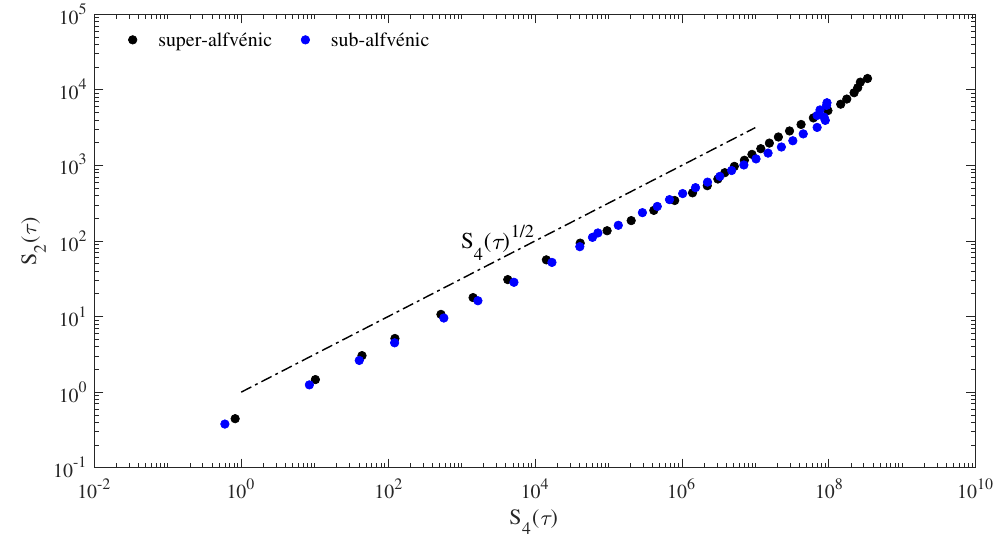
( i ) ( τ ) , vs. 2 ( i ) ( τ ) , for the super-alfvénic (black 4